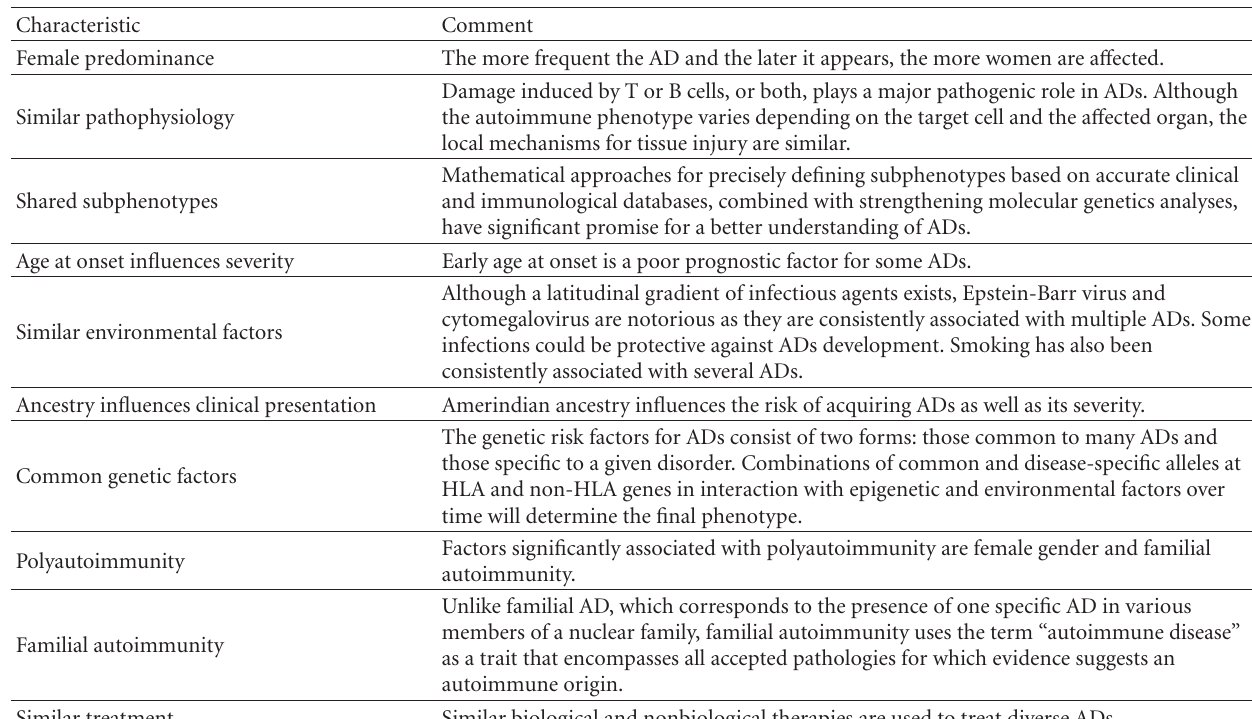
Table 1: Shared characteristics among autoimmune diseases (ADs) supporting the autoimmune tautology ∗